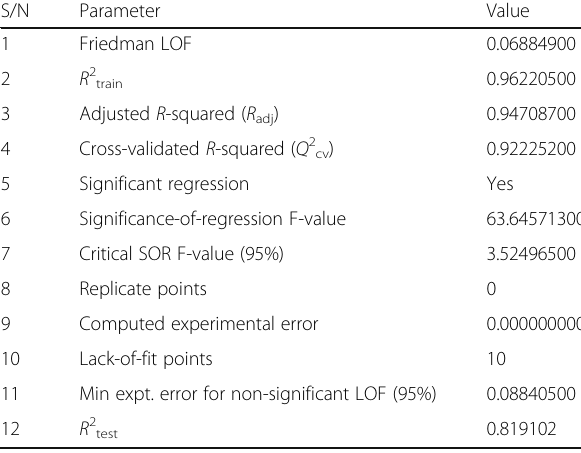
Table 3 Validation parameters for the selected